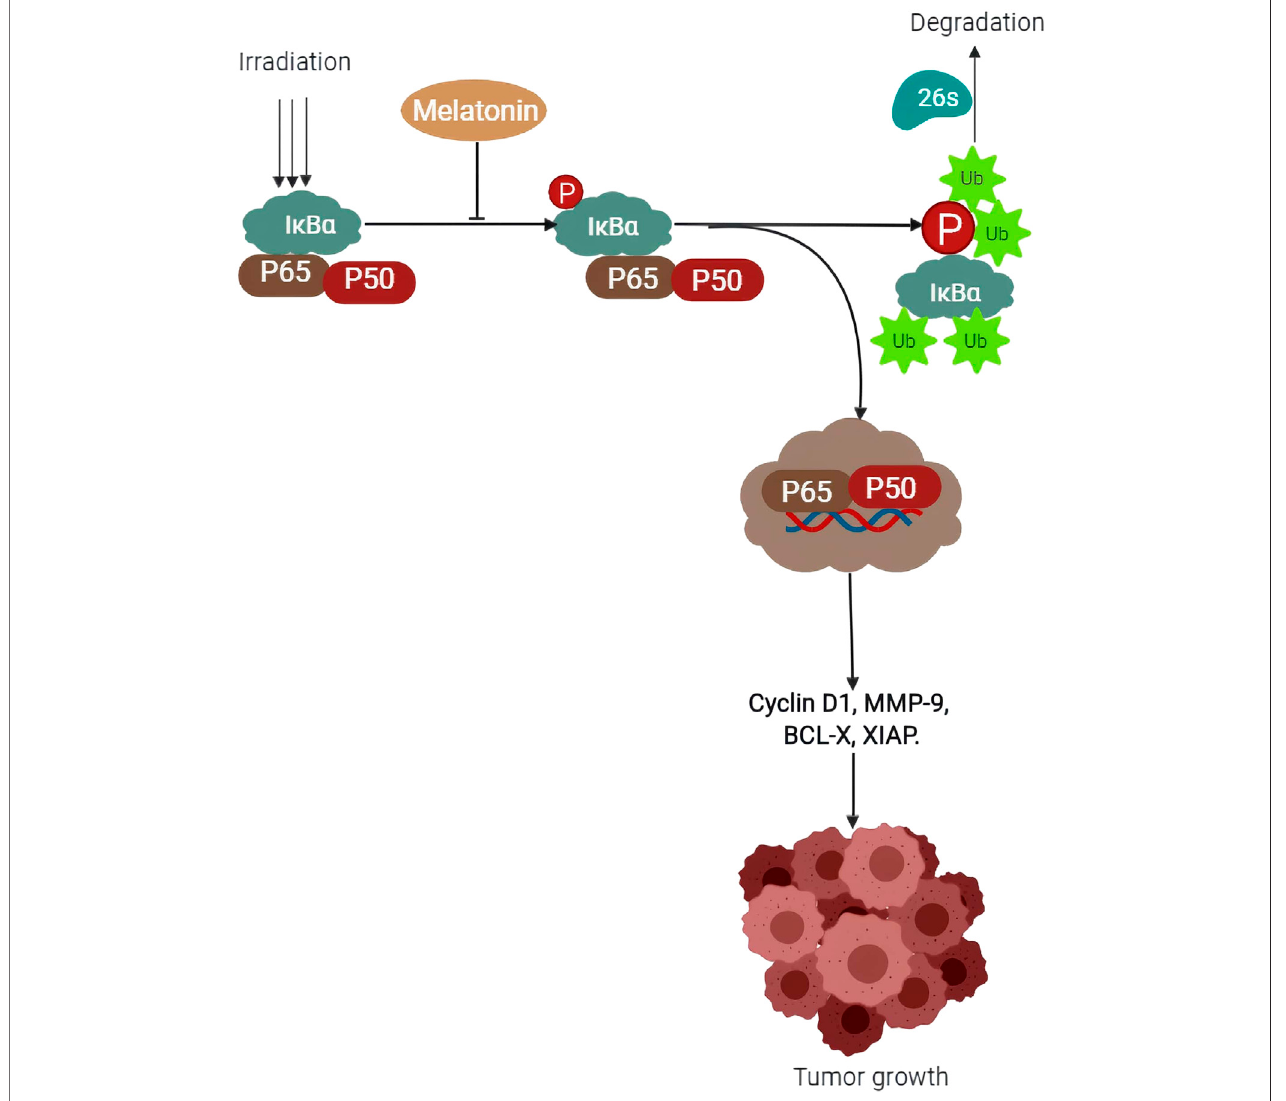
FIGURE 2 | Schematic representation of the proposed mechanism on how melatonin prevents tumor growth by decreasing IK kinase enzyme (IkB α ) phosphorylation.